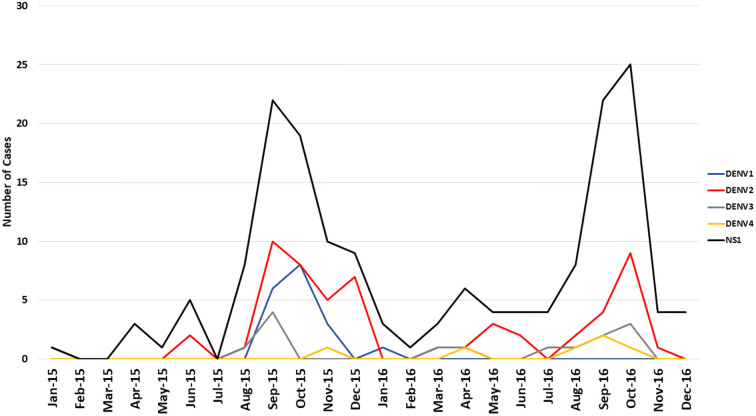
The sustained co-circulation of 4 dengue serotypes in the Sindh region of Pakistan 2015–2017. Data presented represents all RT-PCR positive samples including co-infections and secondary infections.